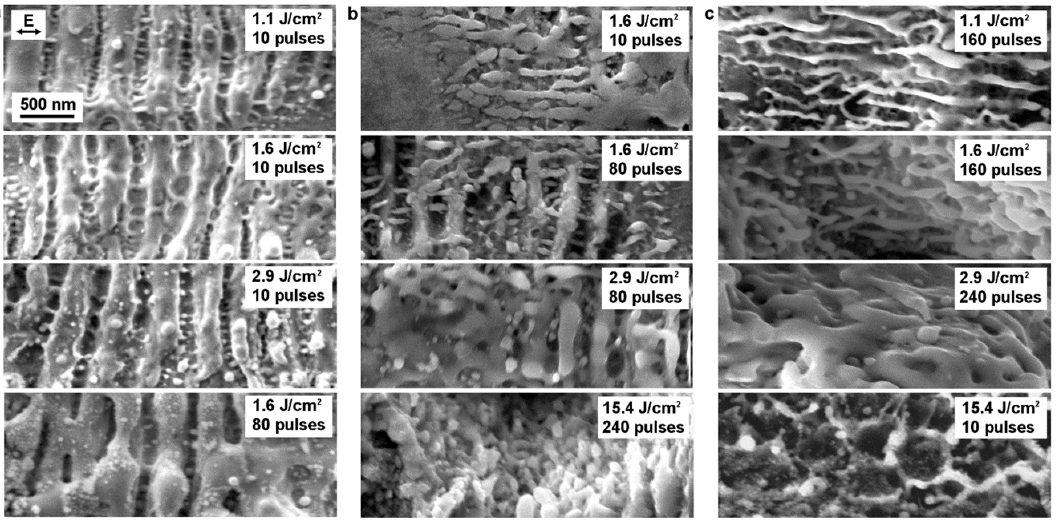
Figure 6. SEM images of irradiated ( a ) Cr, ( b ) Ni, and ( c ) Cu sheets by picosecond laser with varying